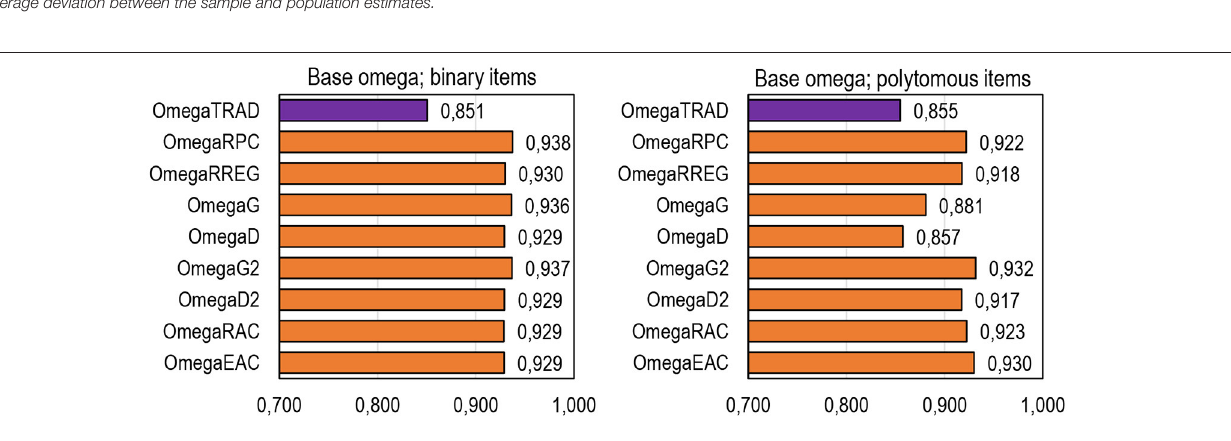
FIGURE 4 | Average estimates by DCERs based on the form of